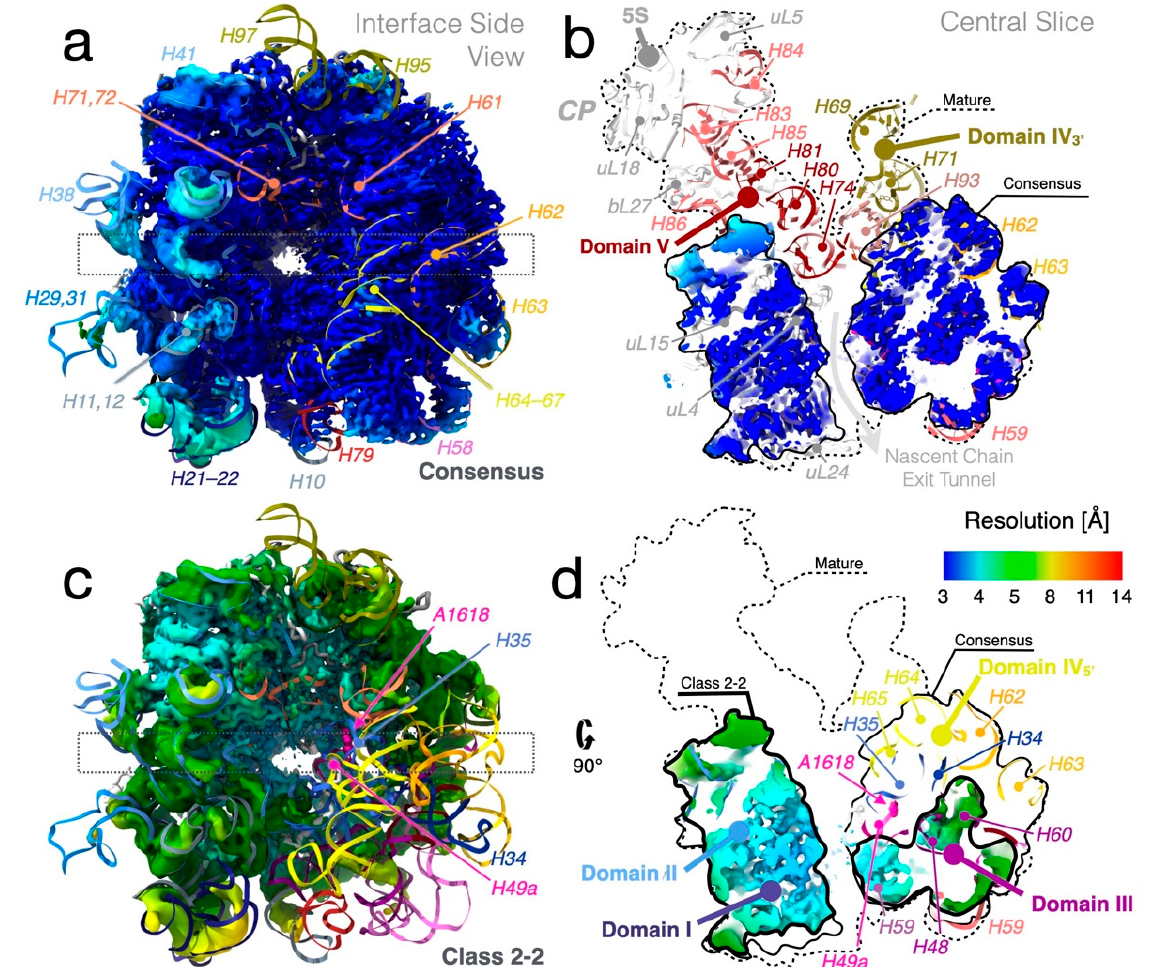
Figure 3. Local resolution and the expanded exit tunnel. ( a ) Consensus reconstruction seen from the interface side, centered on the nascent-chain exit tunnel, colored according to local resolution, with the refined atomic model colored according to Figure 2b. ( b ) Central slice through the map, rectangle in ( a ), showing the expanded exit tunnel and the absence of the CP. The rigid-body fitted model of the mature 50S particle (PDB ID 4YBB [28]) is colored as in Figure 2b. The solid black line indicates the extent of the ordered density and the dashed line indicates the extent of the mature particle. ( c , d ) Class 2-2 in the same view and model as in ( a , b ). In this particle, sub-domain IV 5 ′ and parts of domains II and III are disordered compared to the consensus structure, in particular, nucleotide A1618 in H49a. The thick black line in ( d ) indicates the extent of the density in class 2-2, while the thin and dashed lines are the same as in ( b ).